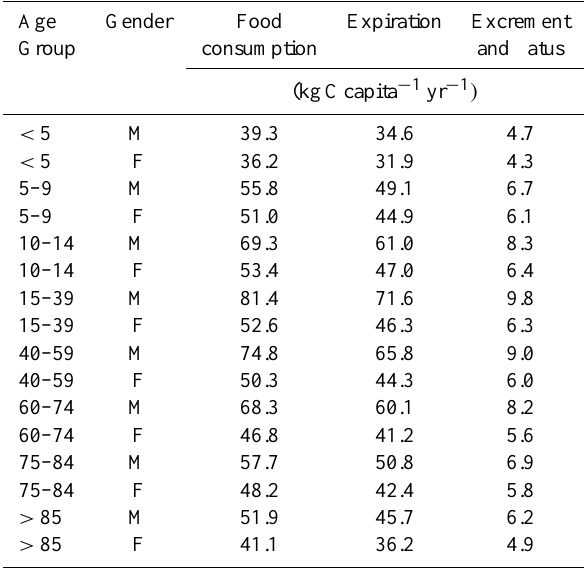
Table 1. Consumption and release of carbon by humans.